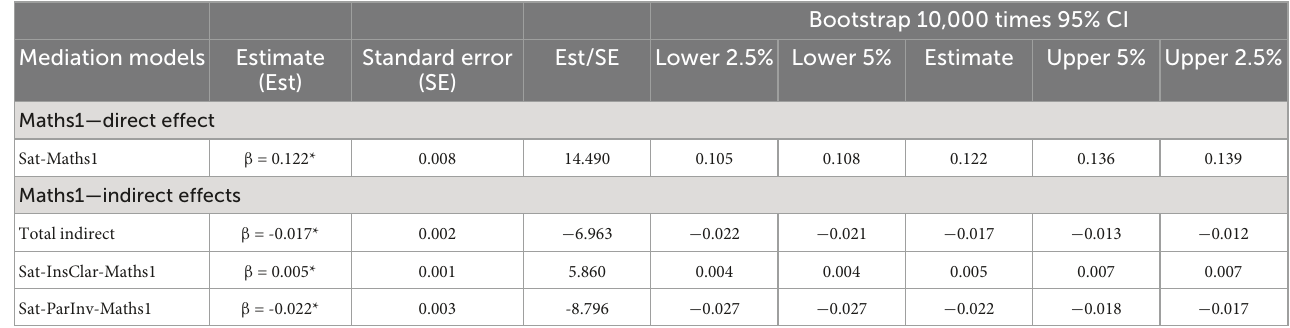
TABLE 5 Standardised direct and indirect